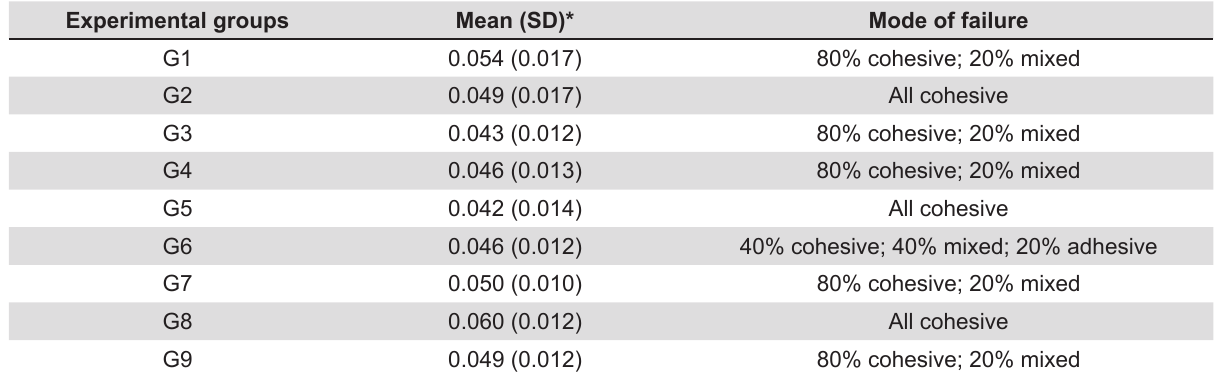
Table 1- Peel strength (MPa) at 24 h